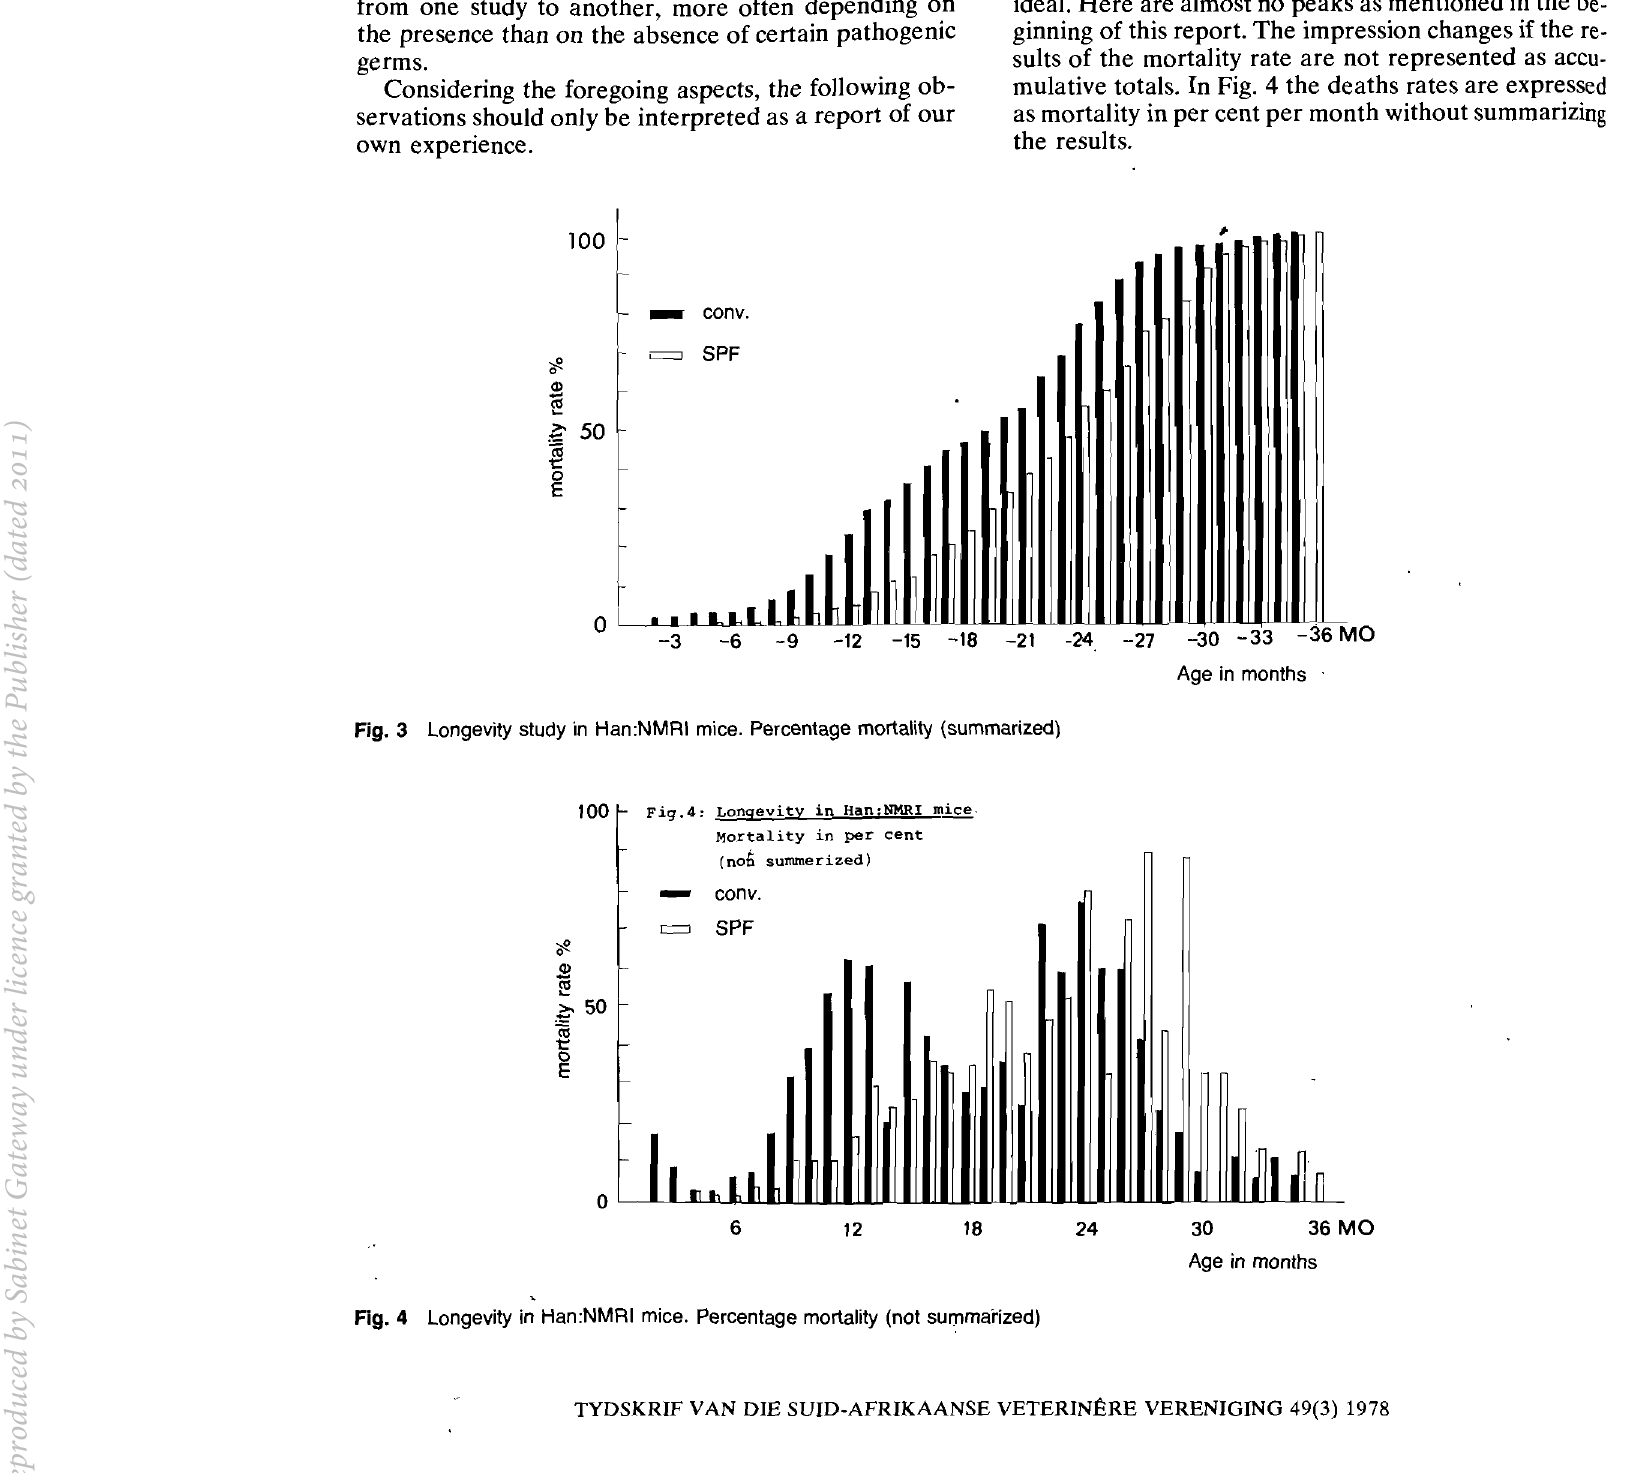
Fig.4 Longevity in Han:NMRI mice. Percentage mortality (not